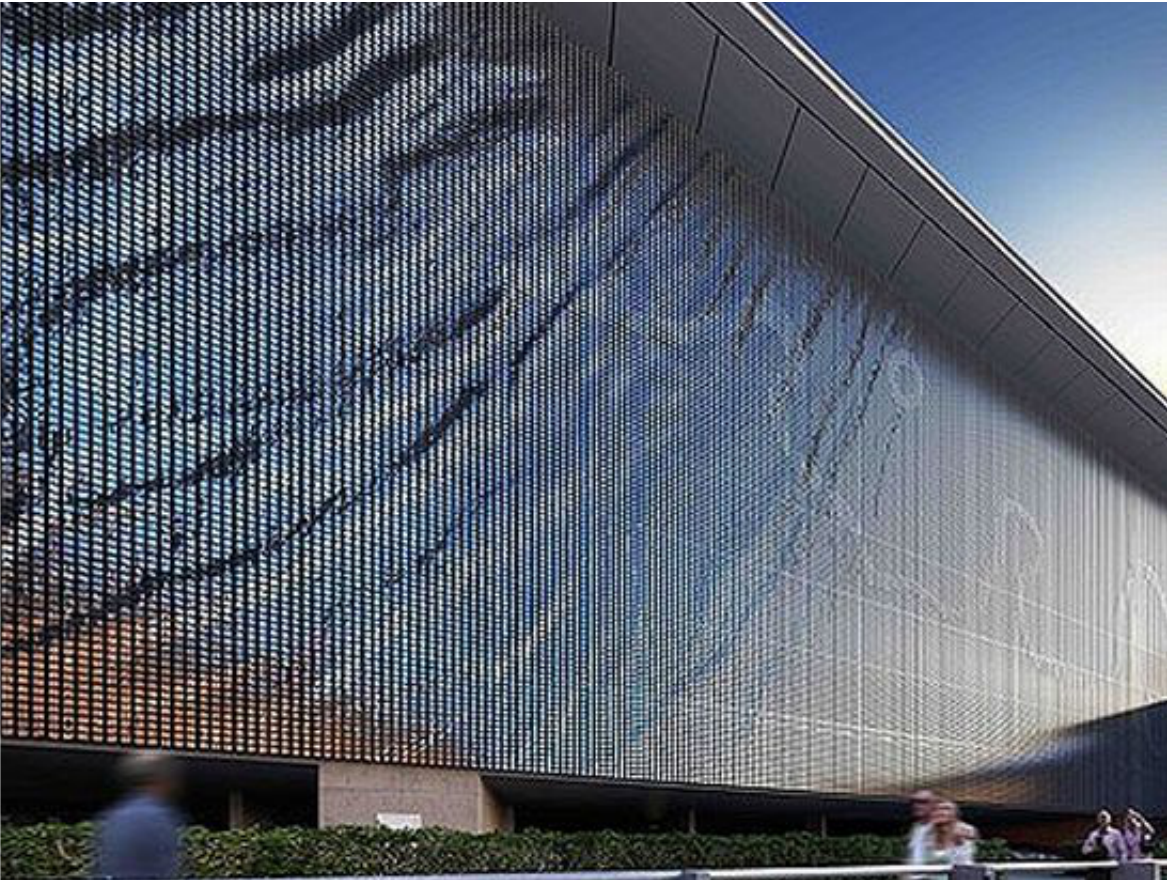
Figure 5. The Ned Kahn kinetic wind sculpture on the wall of the Brisbane Airport,